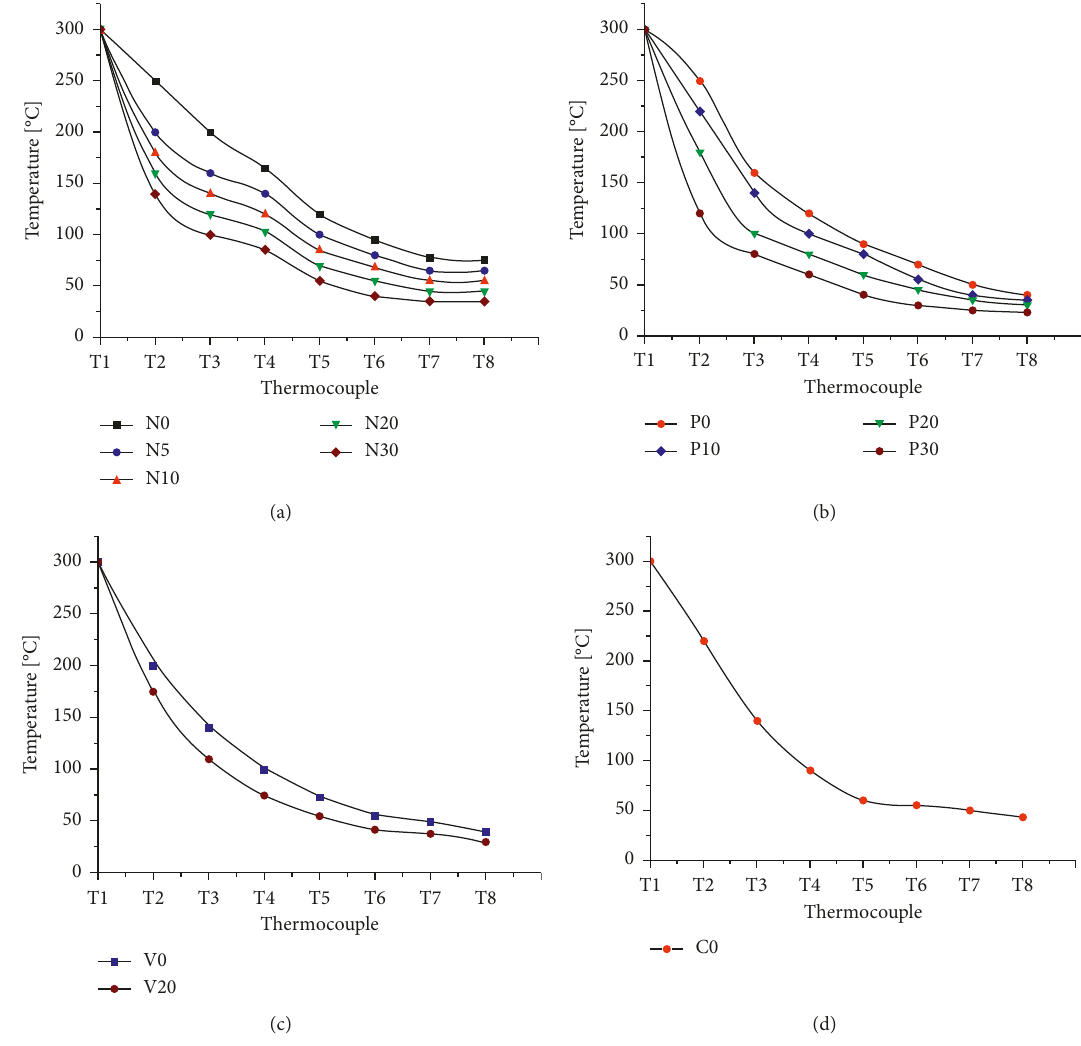
Figure 13: Temperatures across the thermocouples of (a) normal aggregates, (b) pumice aggregates, (c) volcanic rock, and (d) coconut shell aggregate